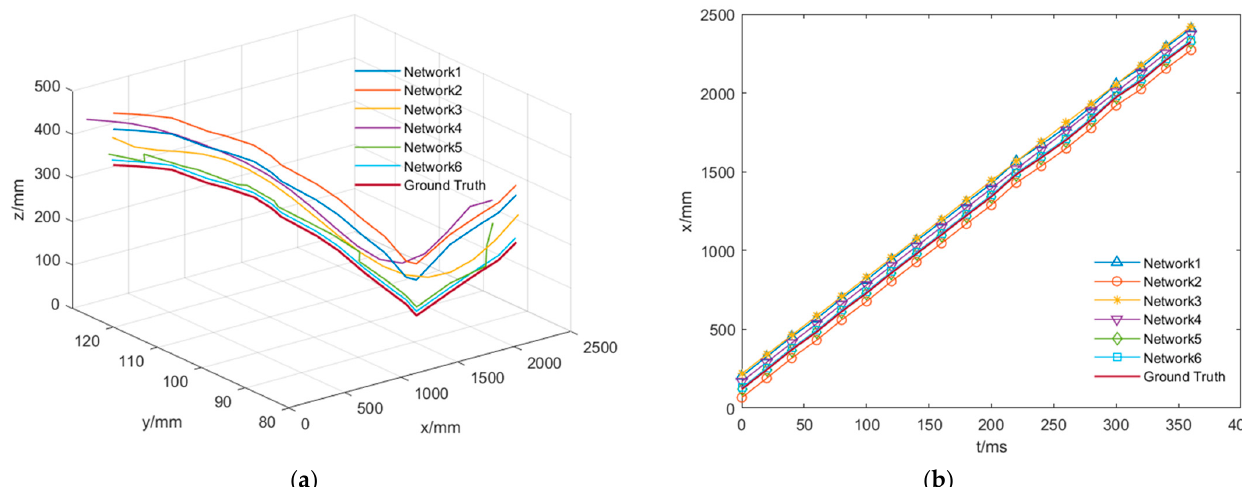
Figure 15. Comparison of target detection results using consecutive frames: ( a ) GroundTruth, ( b ) Network 1, ( c ) Network 2, ( d ) Network 3, ( e ) Network 4, ( f ) Network 5, ( g ) Network 6. Next, spatial modeling of the position information obtained after the horizontal shot over the vertical shot was performed to determine the sphere motion trajectory. In this control experiment, GroundTruth samples were acquired by depth camera shots, and the rest of the motion trajectories were gained by the method described in this article. In Figure 16, the comparisons are displayed, respectively. trajectory of the sphere.